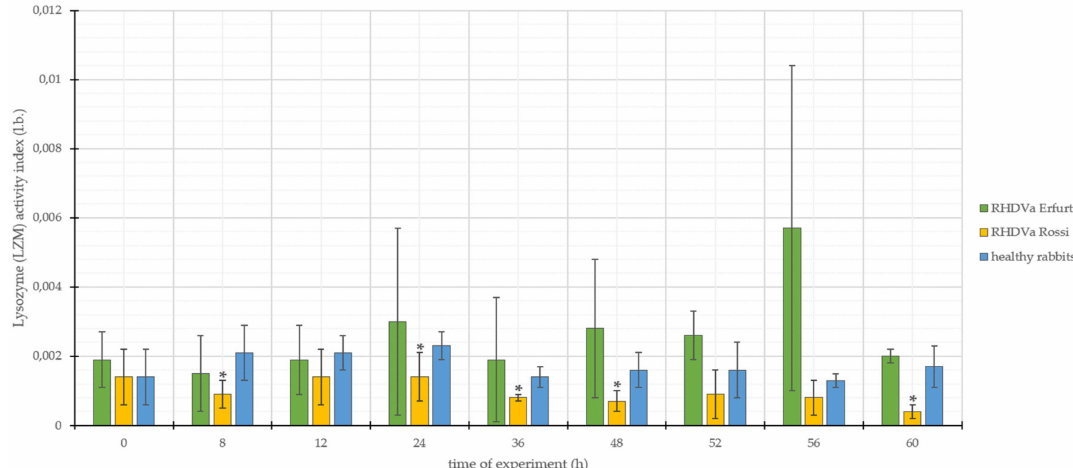
Figure 4. Values of lysozyme (LZM) activity in rabbits infected with L. europaeus / GI.1a / Erfurt and L. europaeus / GI.1a / Rossi, as well as control rabbits. * statistically significant change respect to the control group ( p <